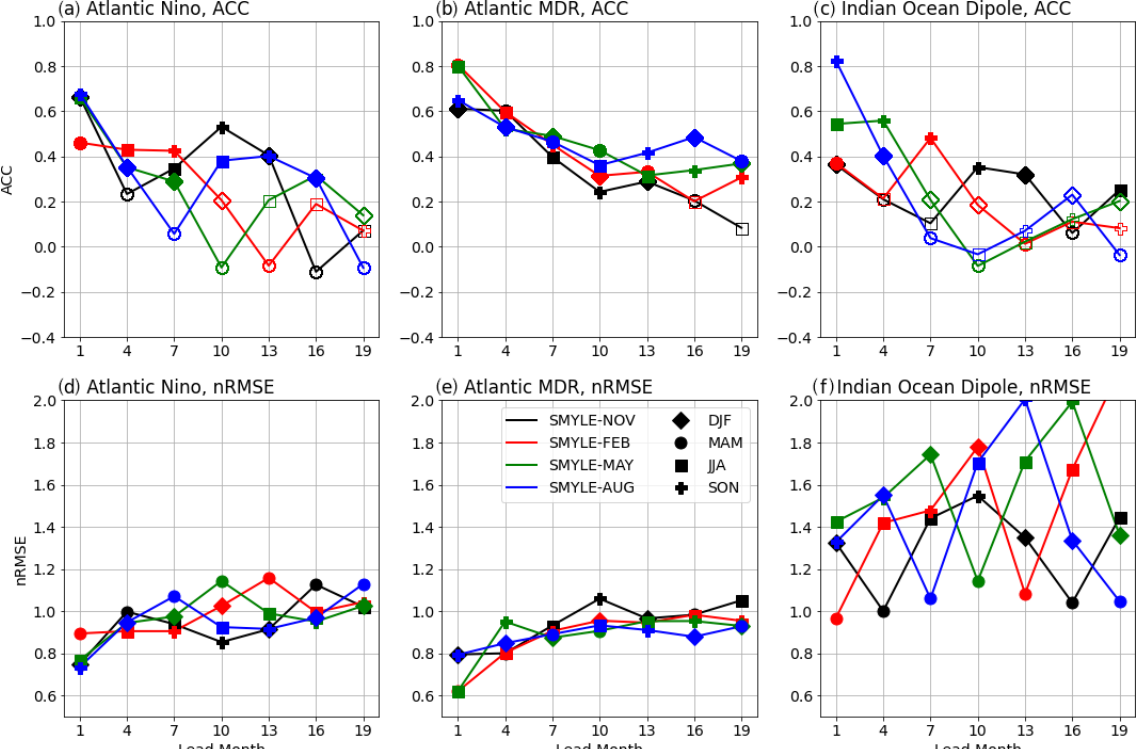
Figure 5. Anomaly correlation (a, b, c) and normalized RMSE (d, e, f) skill scores for regionally averaged seasonal SST indices as follows: (a, d) Atlantic Niño (3 ◦ S–3 ◦ N, 20–0 ◦ W), (b, e) Atlantic main development region (MDR; 10–20 ◦ N, 80–10 ◦ W), and (c, f) Indian Ocean Dipole (10 ◦ S–10 ◦ N, 50–70 ◦ E minus 10 ◦ S–0 ◦ N, 90–110 ◦ E). Scores for individual SMYLE start months (colors) are shown as a function of lead month, with verification season indicated by symbols as shown in the legend. Filled symbols for ACC indicate significant correlation scores ( p < 0.1). Time series were detrended prior to skill score computation. The verification dataset is